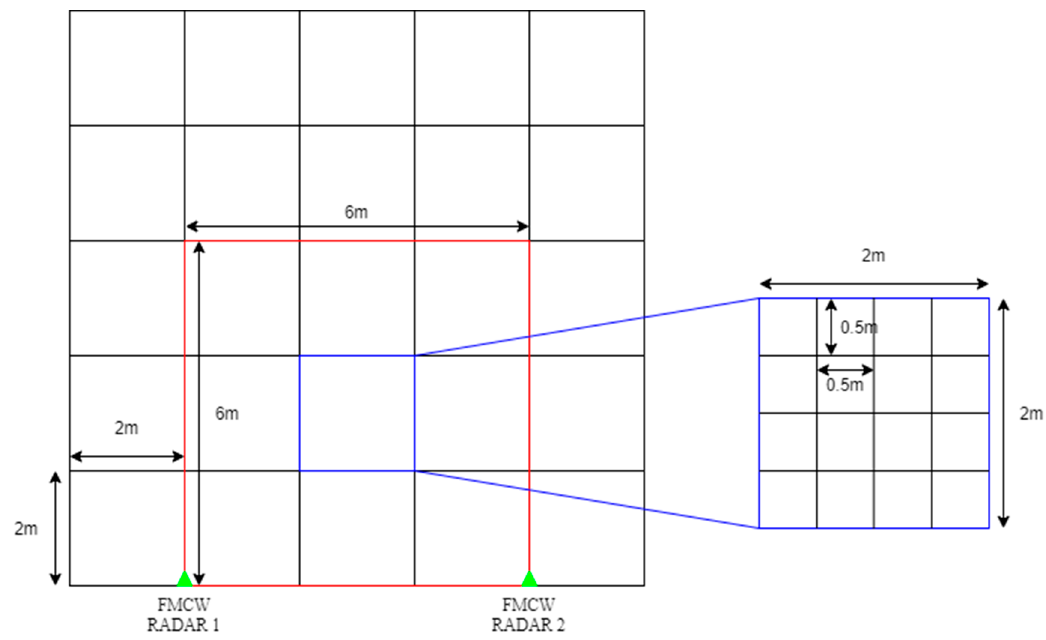
Figure 16. Actual measurement area.